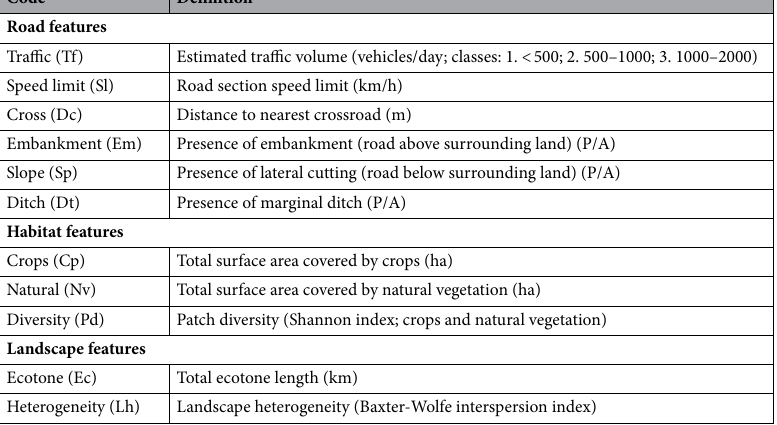
Table 2. Variables measured to model the factors affecting hare–vehicle collision locations. Road features were measured at each collision point. Habitat-level variables were measured in a 100 m radius buffer around each collision point, while landscape-level variables were measured in a 500 m radius buffer. P/A